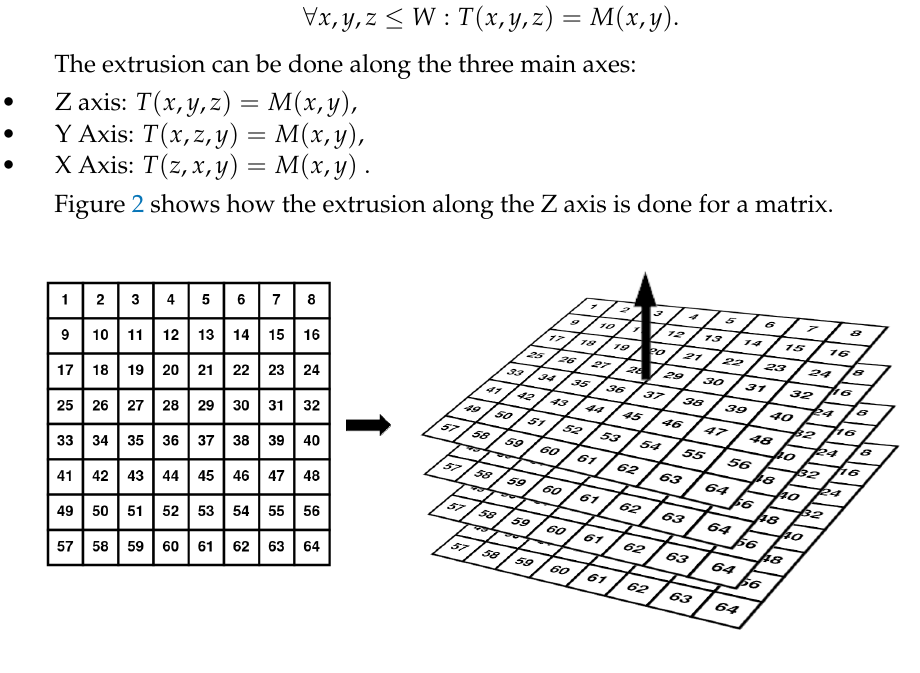
Figure 2. Extrusion along Z axis of a 2D matrix to generate a 3D